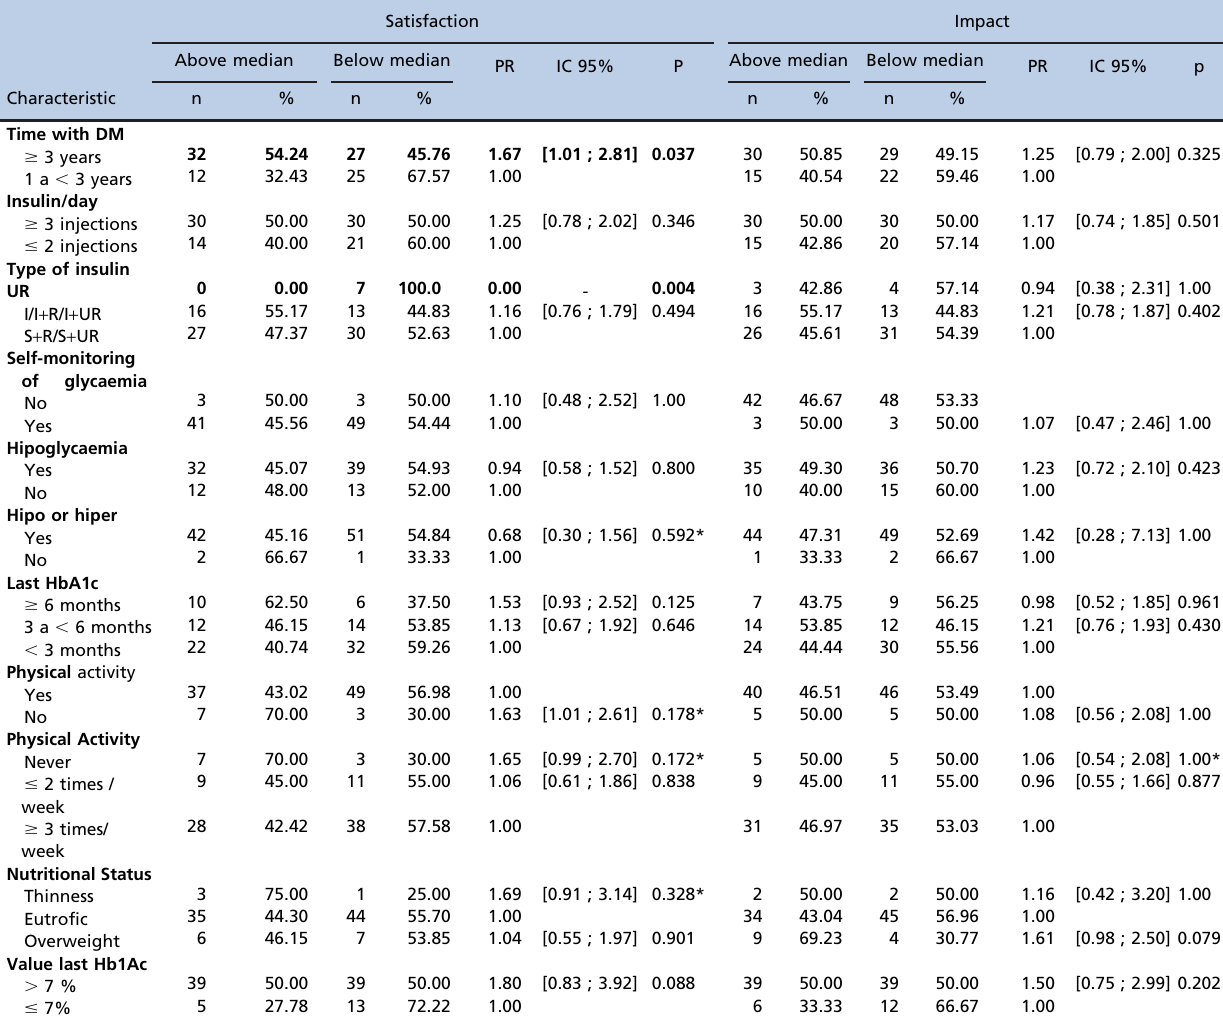
Table 4, Line 5: where it reads . 3 years it should read $ 3 years. Table 4, Line 6: where it reads 1 - 3 years it should read 1 at , 3